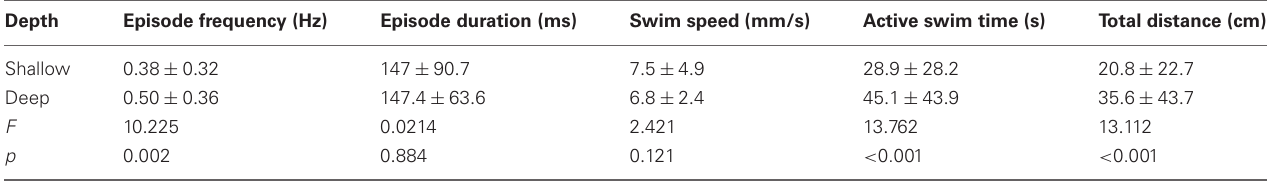
Table 2 | Comparison of the properties of locomotor activity for larvae in behavioral wells of different depths.